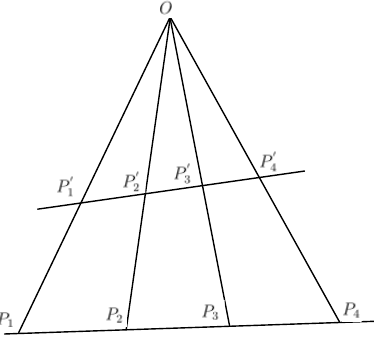
Figure 6. Illustration of cross-ratio constraint in the image